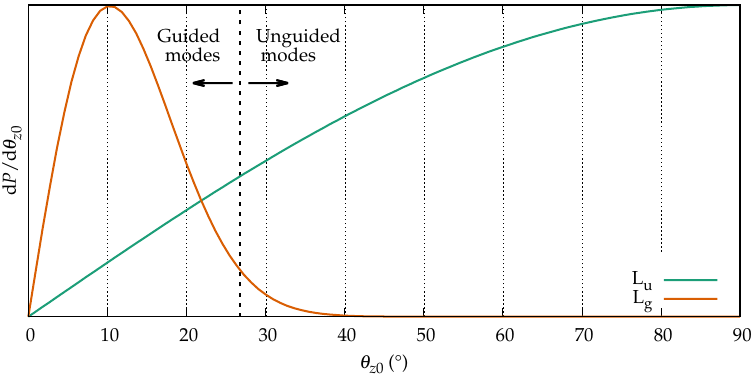
Figure 8. Normalized power distributions of the light